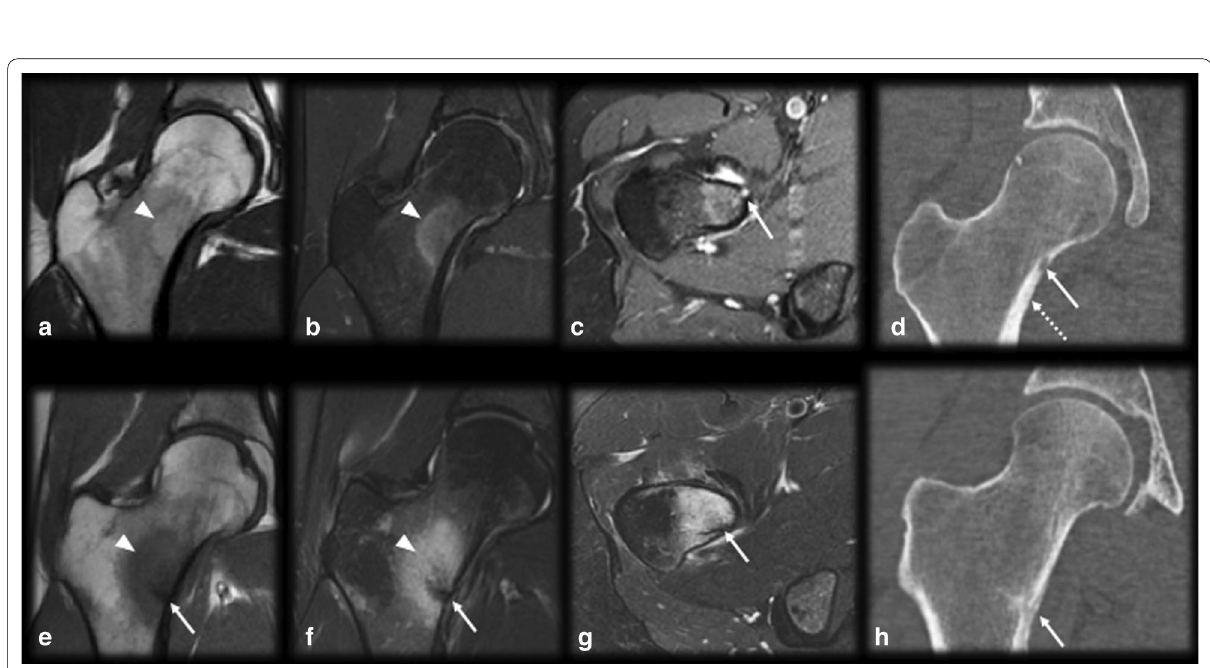
Fig. 9 Osteoid osteoma versus calcar femorale stress fracture. ( a – d ) Male, 35 years old, presenting with hip pain for 3 months. MRI T1 ( a ) and T2 FS ( b ) showed bone marrow edema on the femoral neck (arrowhead), T1 FS GD ( c ) and CT ( d ) showed a small nonmineralized nidus (arrows) with gadolinium enhancement ( c ) and mild cortical thickening (dotted arrow in d). ( e – h ) Male, 33-year-old runner, presenting with hip pain for 2 weeks, which worsened during running workouts. MRI T1 ( e ) and T2 FS ( f , g ) showed bone marrow edema on the lower femoral neck (arrowhead) and a cortical fracture line (arrows), which was also seen on the CT scan ( h )